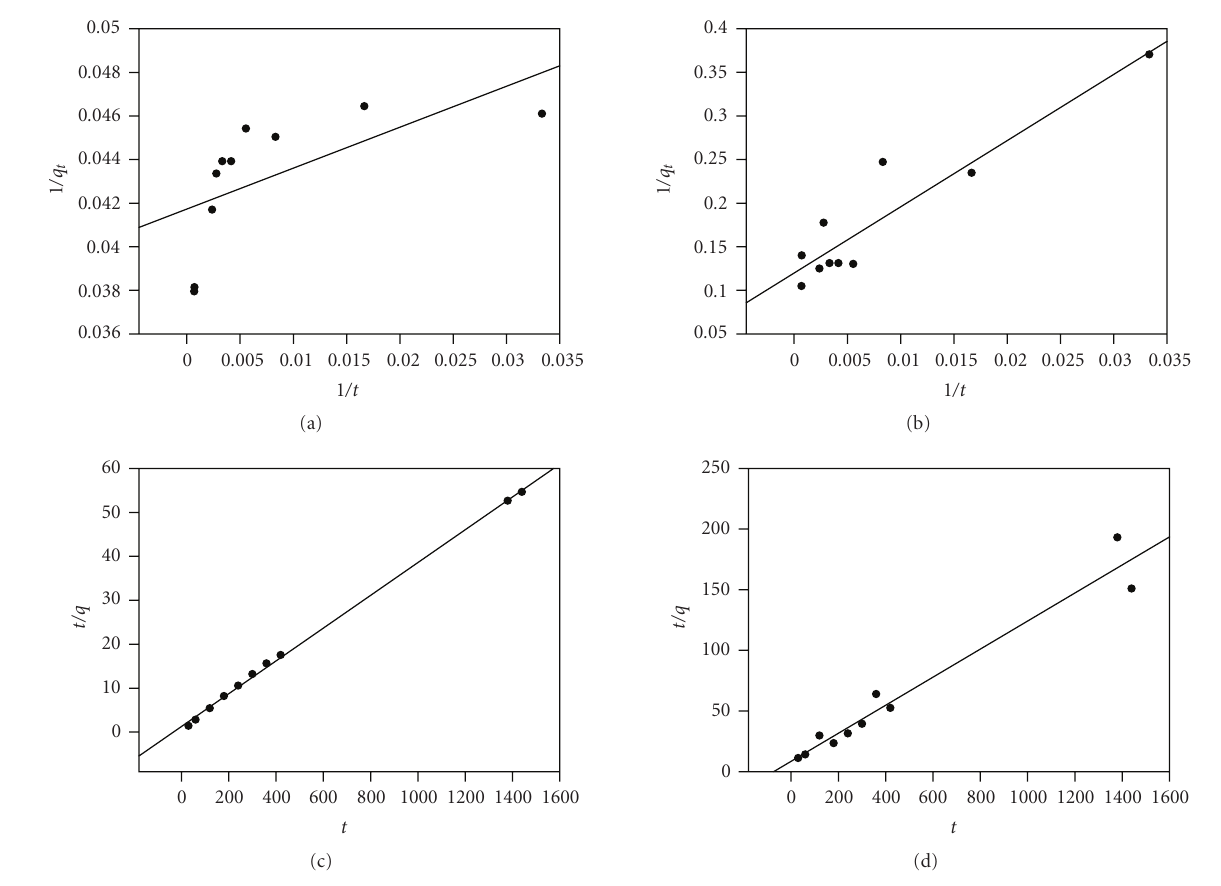
Figure 3: Kinetic plots at initial dye concentration of 650mg l − 1 . First-order plots for (a) sample A and (b) sample C. Second order plots for (c) sample A and (d) sample